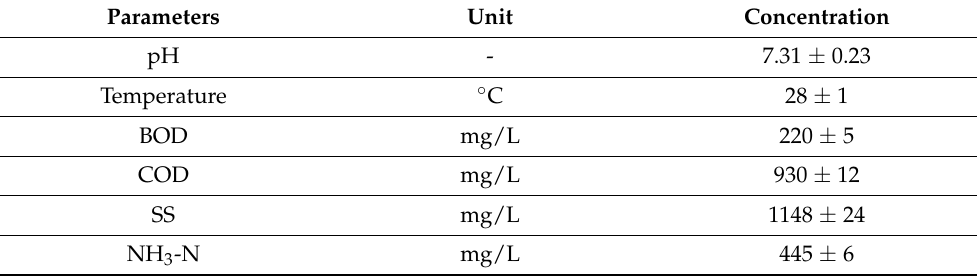
Table 1. Physicochemical properties of untreated